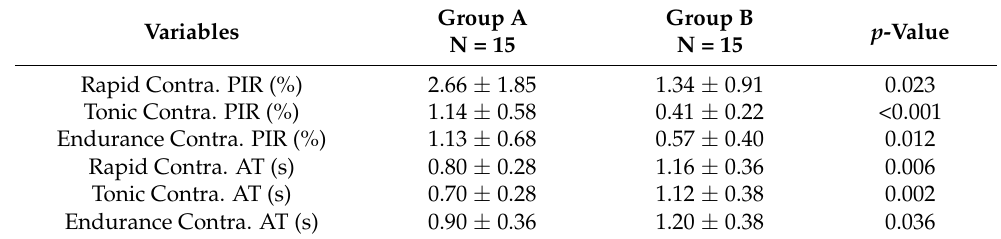
Table 2. Comparison of pressure-related parameters, control (Group A), PSUI participants (Group B). Variables